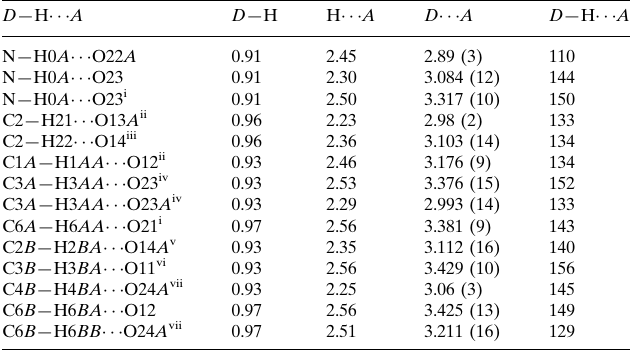
Hydrogen-bond geometry (A˚ , (cid:2)